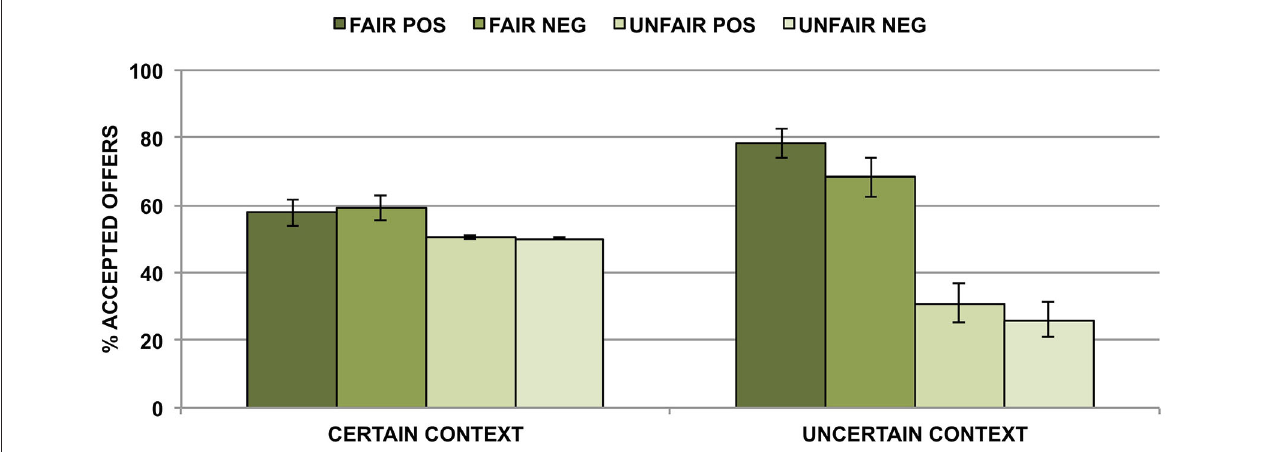
FIGURE 2 | Acceptance rates for fair and unfair offers following positive and negative descriptions of the interaction partners in certain and uncertain contexts. Error bars represent standard error of the